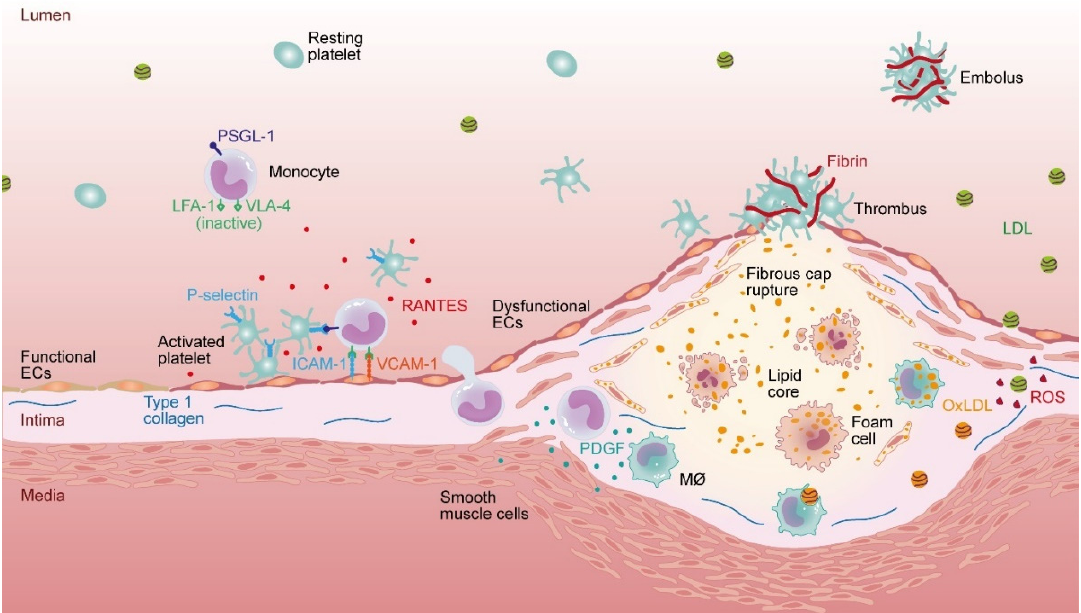
Figure 1. Cellular pathomechanisms of atherogenesis and progression. Environmental risk factors such as cigarette smoking and hypercaloric diet or preexisting conditions such as hypercholesterolemia, hyperglycemia or hypertension promote endothelial dysfunction and increase vascular permeability and retention of LDL in the vascular intima. Endothelial dysfunction further promotes platelet adhesion through the release of von Willebrand factor (vWF) and platelet activation by mediators such as adenosine diphosphate (ADP) and thromboxane (TxA2). Activated platelets secrete the chemokine RANTES (CCL5), which enables monocytes to adhere under flow conditions. The adhesion is further promoted by cellular adhesion molecules (CAM) expressed by activated endothelial cells. The lymphocyte function-associated antigen 1 (LFA-1) on the surface of monocytes enables their binding to intercellular adhesion molecule 1 (ICAM-1) expressed by endothelial cells. This cellular interaction is strengthened by monocytic integrin α 4 β 1 (VLA-4) binding to vascular cell adhesion molecule 1 (VCAM-1), further mediating lateral migration and transendothelial diapedesis of monocytes into the intima. Intimal LDL is oxidized by ROS to oxidized LDL (oxLDL), which aids in the recruitment of monocytes and initiates differentiation into macrophages by scavenger receptor mediated uptake of oxLDL. Activated macrophages secrete platelet-derived growth fac- tor (PDGF), which stimulates smooth muscle cells (SMCs) to migrate into the intima where they proliferate and produce extracellular matrix and again incorporate oxLDL. Uptake of oxLDL by SMC and macrophages leads to their differentiation into foam cells, which degrade and, in turn, release oxLDL. This self-amplifying process further attracts macrophages and SMCs that accumulate oxLDL and dying cells—the necrotic core of the atheromatous plaque. This process is accompanied by thickening of the intima limiting blood flow through the lumen and results in weakening of the fibrous cap of the vulnerable plaque. As the disease progresses, the vascular lumen becomes gradually occluded, leading to turbulent blood flow, which supports endothelial dysfunction, the expression of CAMs, and the formation of vascular lesions. Increasing instability culminates in plaque rupture and subsequent thrombus